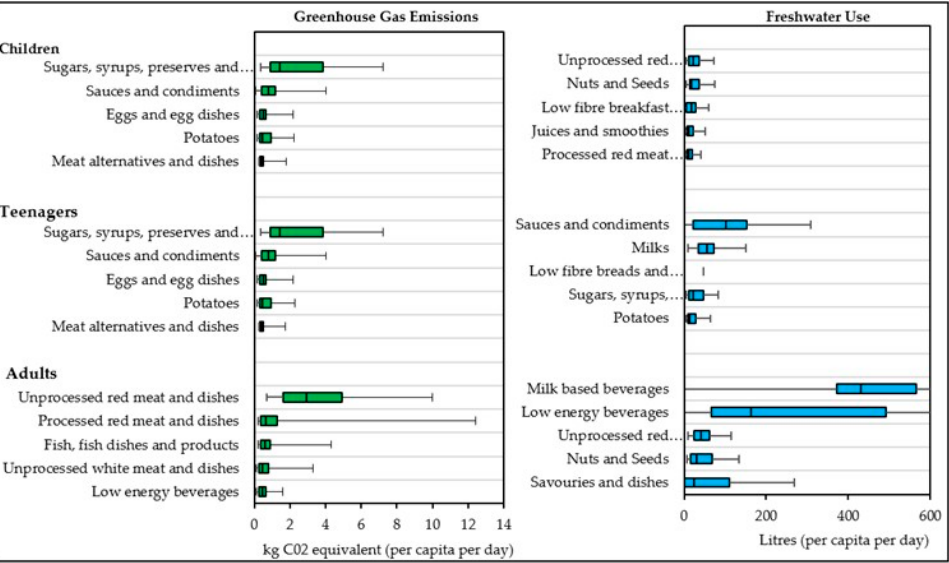
Figure 3. The main contributors to greenhouse gas emissions and blue water use across the population groups by actual intake amounts. Values shown as median, interquartile range (IQR) with 95% confidence intervals shown. Highest median contribution to each factor shown.